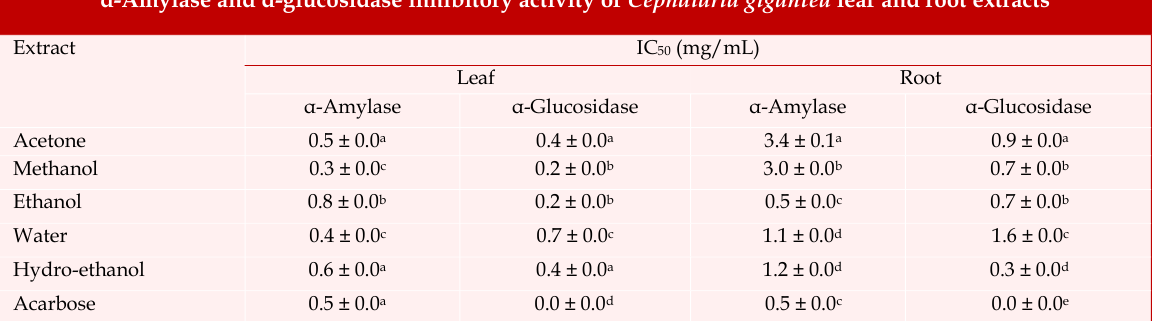
α - Amylase and α - glucosidase inhibitory activity of Cephalaria gigantea leaf and root